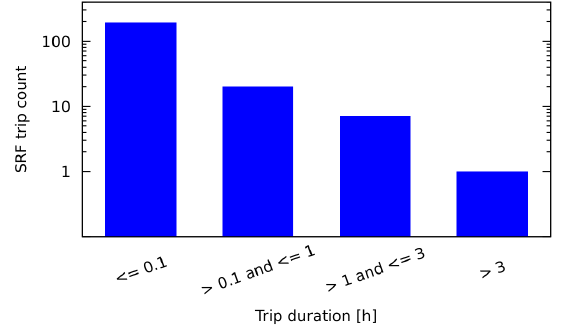
FIG. 6. Distribution of SRF trips in FY20 by their duration.